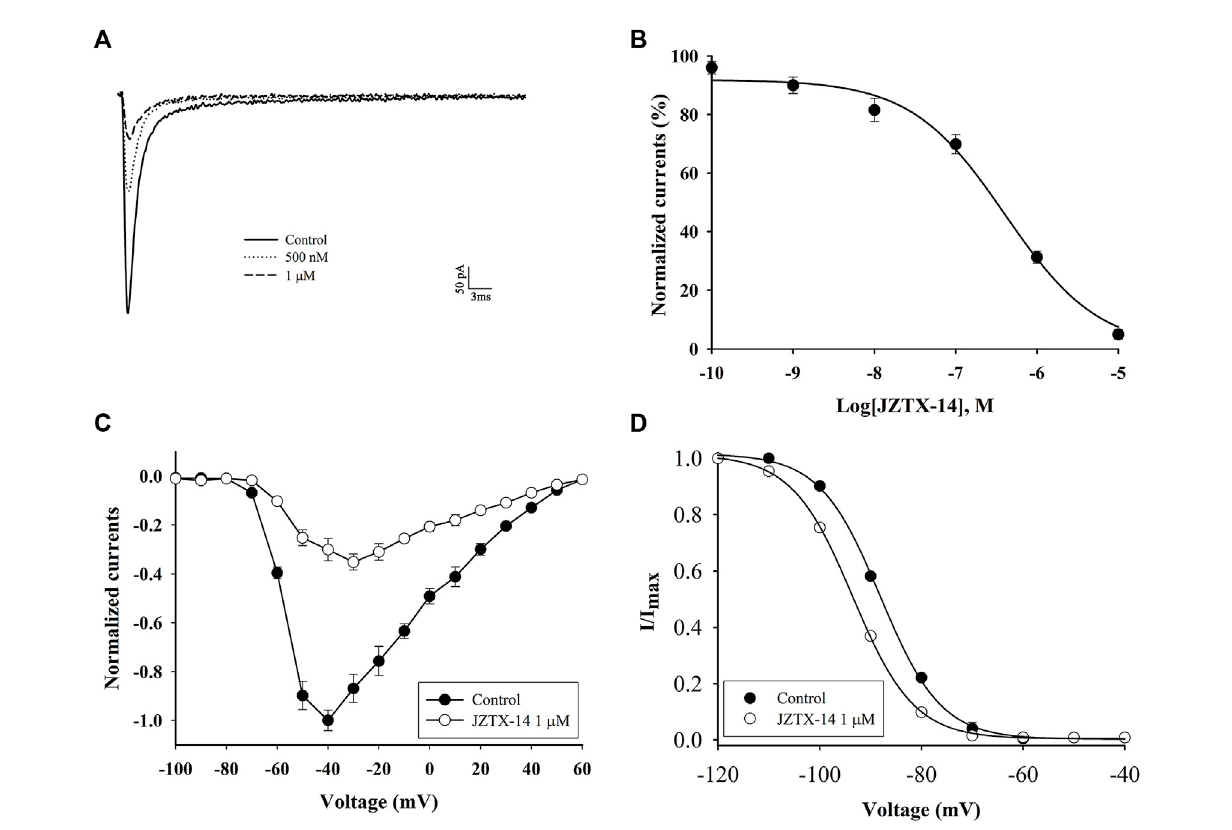
FIGURE 3 JZTX-14 inhibited the sodium current in MDA-MB-231 cells. (A) Inhibition of sodium current by 500 nM and 1 μ M JZTX-14; (B) Dose-dependent inhibition of sodium current by 1 μ M JZTX-14; (C) The current-voltage (I – V) curves of sodium currents show the average relationship of current trajectories before and after toxin treatment. The series ofcurrent trajectories before and after adding 1 μ M JZTX-14 at50 ms depolarisation ataholding potential of − 100 mV to various potentials. (D) Inactivation kinetics inhibition of sodium currents by 1 μ M JZTX-14. Data points (6 cells per point) show currents relative to control current